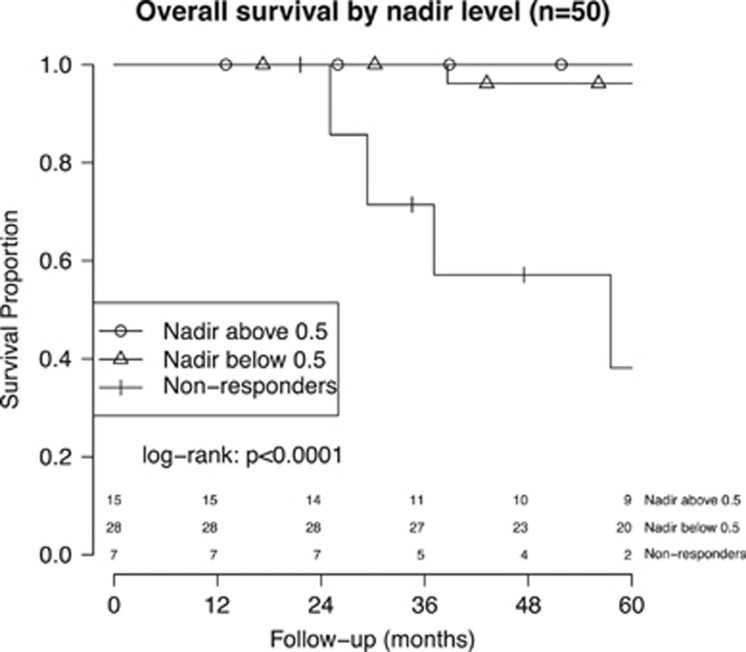
Overall survival by nadir status.